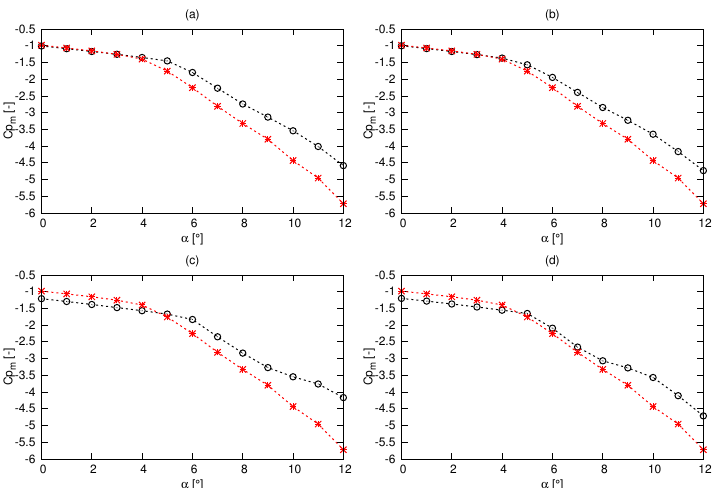
Figure 16. Reference and optimized hydrofoils of the second case of 2-D optimization, where ( a ) is optimized hydrofoil HF-2D-2-1, ( b ) is optimized hydrofoil HF-2D-2-2, ( c ) is optimized hydrofoil HF-2D-2-3 and ( d ) is optimized hydrofoil HF-2D-2-4. The red solid lines denote the optimized hydrofoil and the blue dash-dot lines denote the original hydrofoil.